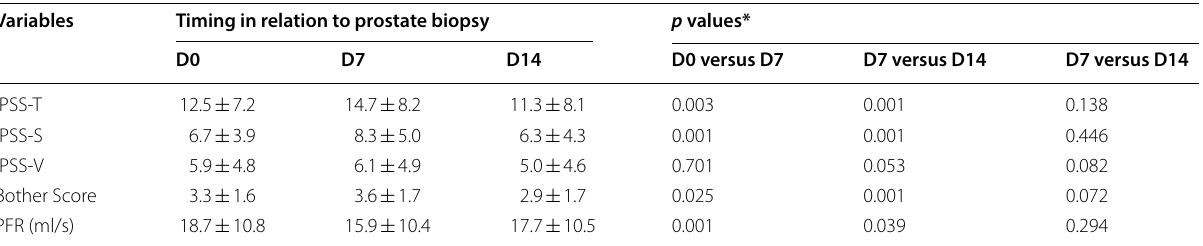
Table 2 Comparison of the baseline and post-biopsy IPSS, bother score and PFR in patients who voided after prostate